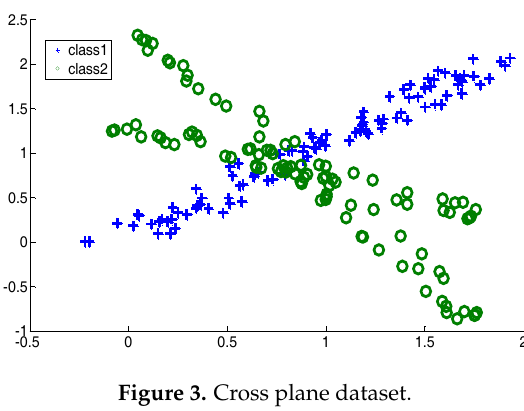
Figure 2. Exclusive OR dataset.